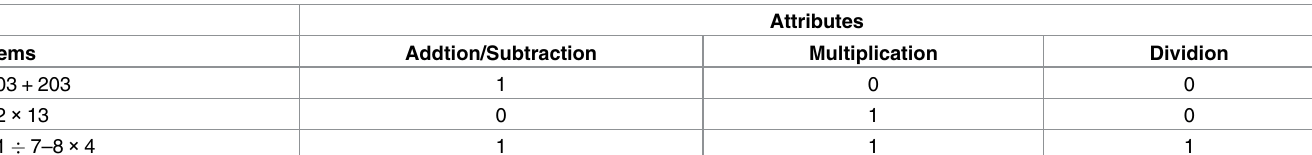
Table 1. Example of a